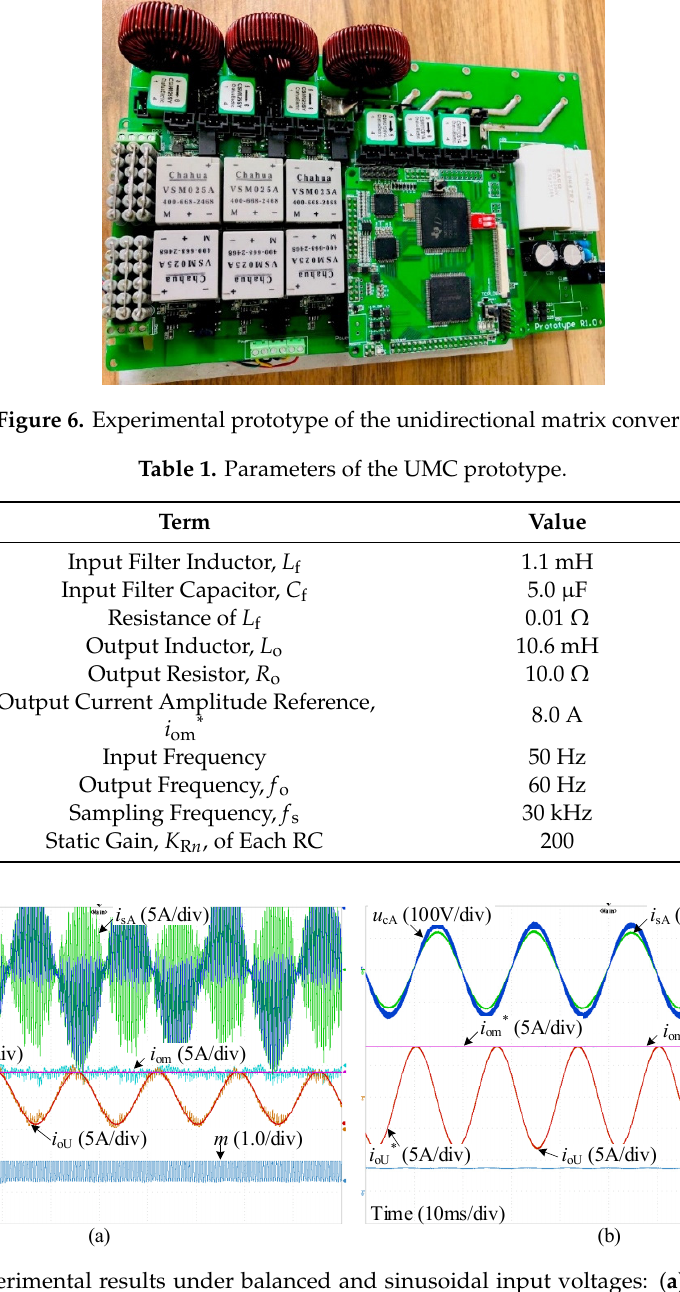
Figure 7. Experimental results under balanced and sinusoidal input voltages: ( a ) with traditional modulation scheme; ( b ) with the proposed modulation scheme.